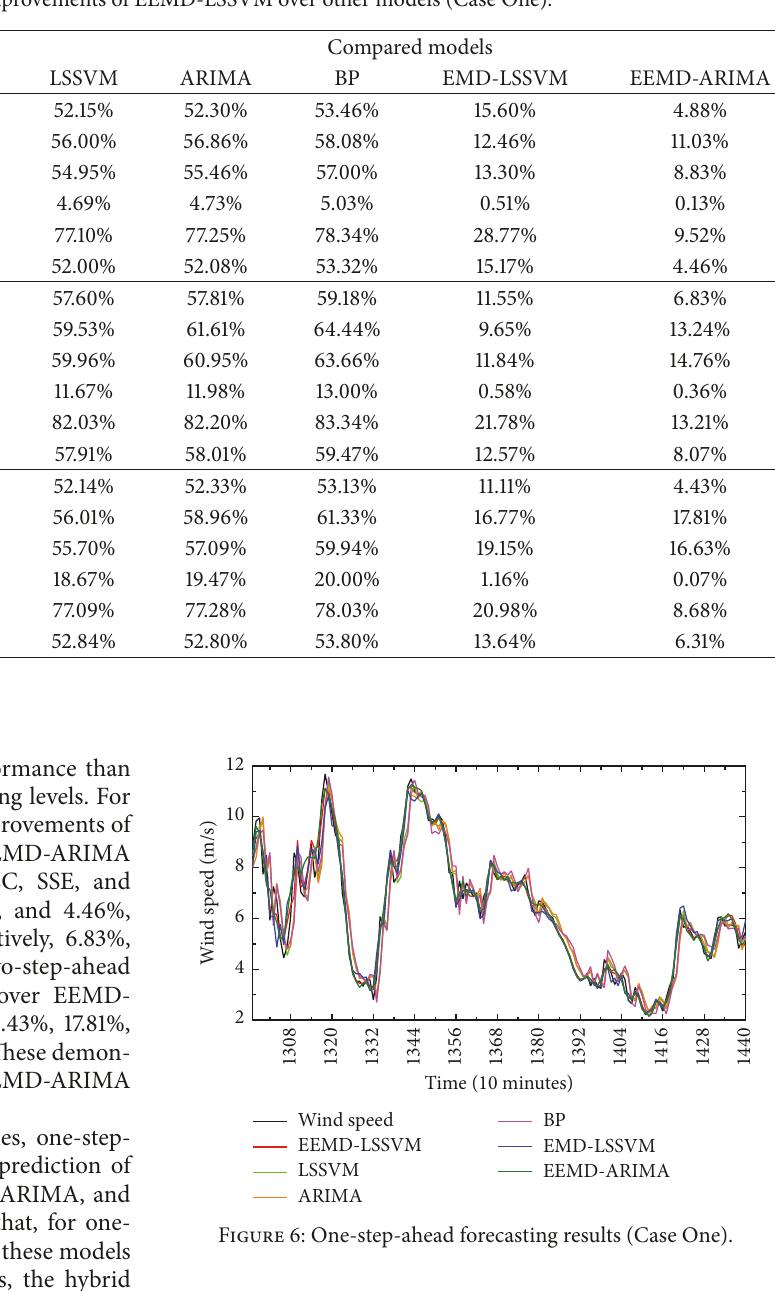
Table 4: The percentage improvements of EEMD-LSSVM over other models (Case One).